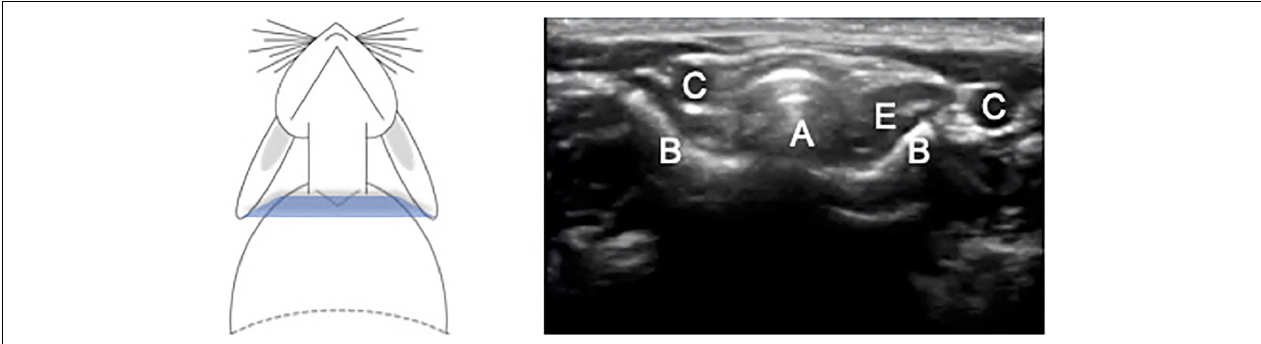
Right endobronchial intubation with a cuffless, reinforced, extra soft, single lumen tube, 2.5 mm (MallinckrodtTM, Covidien R (cid:13) , United States) with an internal and external diameter of 2.5 mm and 4.0 mm, respectively. The SLT was the same that provided tracheal intubation.